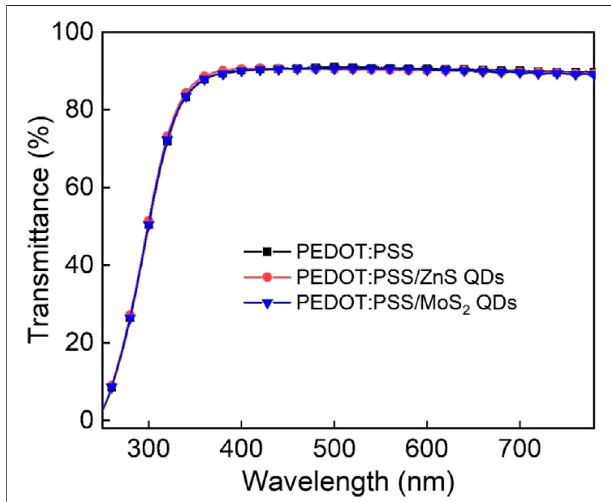
FIGURE 5 | The optical transmittance spectra for neat PEDOT:PSS, PEDOT:PSS/10% ZnS QDs and PEDOT:PSS/10% MoS 2 QDs fi lms.